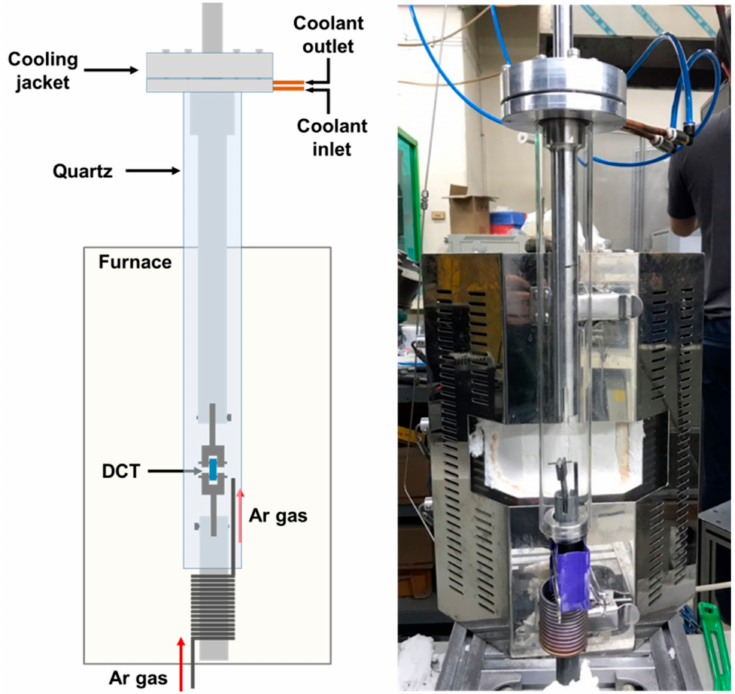
Figure 3. The schematics of fatigue pre-cracking set-up in high-temperature Ar